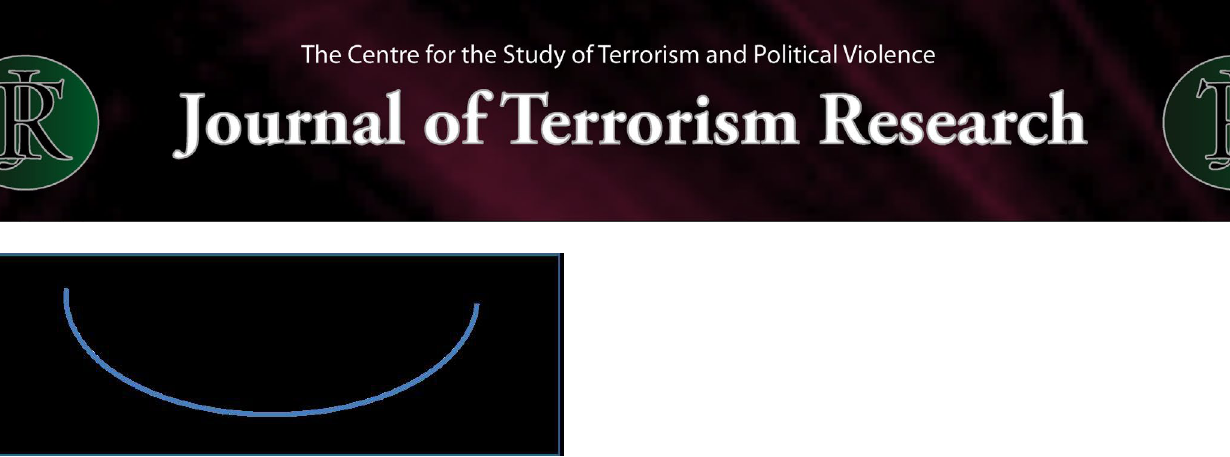
Figure 3: Arcing pattern of glorious-past‒inglorious-present‒glorious future that successfully overcomes a group’s natural resistance to messages of